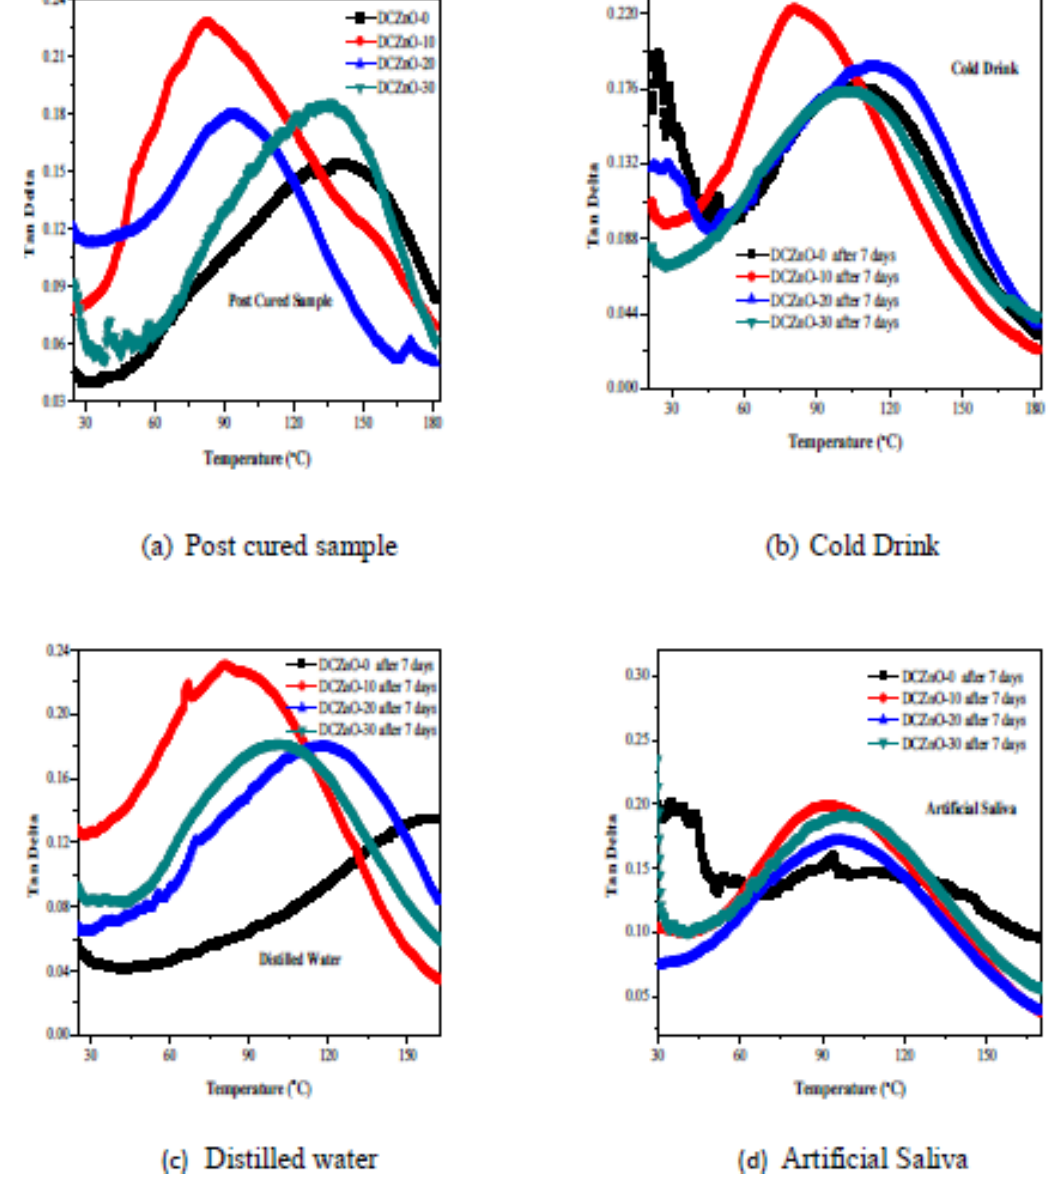
Figure 5: Variation of Tan delta of (a) Post cured sample (b) sample kept in Cold Drink for 7 days (c) sample kept in distilled water for 7 days (d) sample kept in artificial saliva for 7